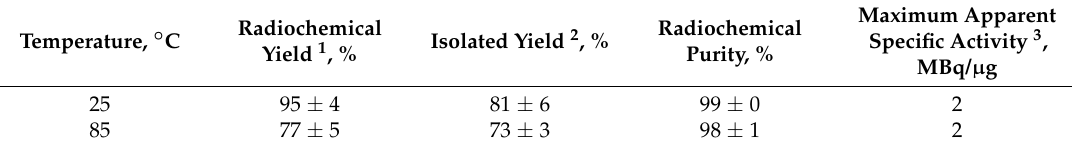
Table 1. Labeling of DFO ‐ ZEGFR:2377 using gallium ‐ 68.